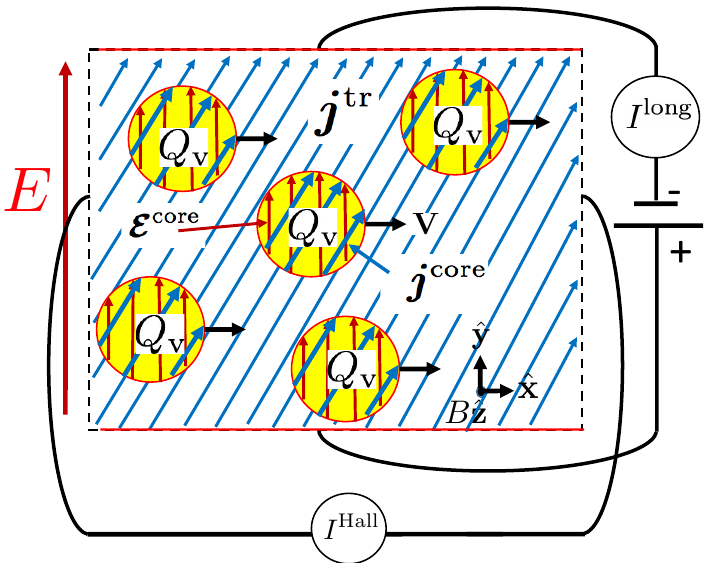
Figure 3: Flux flow steady state transport. The electric field dictates the mean vortex velocity according to Josephson relation V = c an ideal current pump of both longitudinal and Hall components j core . The core cur- rents combine to a transport current density j tr = j core marked by long blue arrows. Moving vortex charges of average magnitude Q which is responsible for the Hall